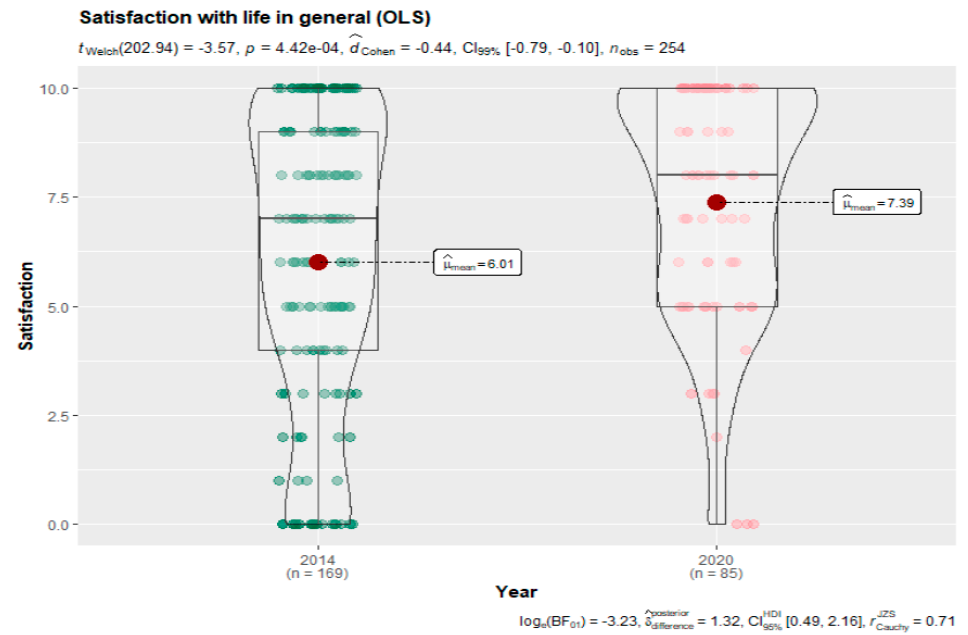
Figure 3. Comparison of means for satisfaction with life in general (OLS) among girls by year of data collection .